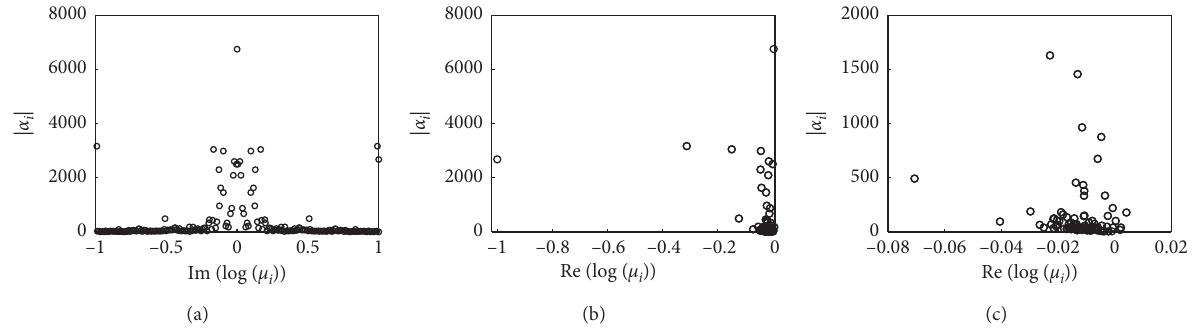
Figure 4: The absolute value of the DMD amplitudes α i distribution versus (a) the frequency and (b) the real part of the corresponding DMD eigenvalues μ i for the 200hPa jet. (c) A zoomed version of (b).